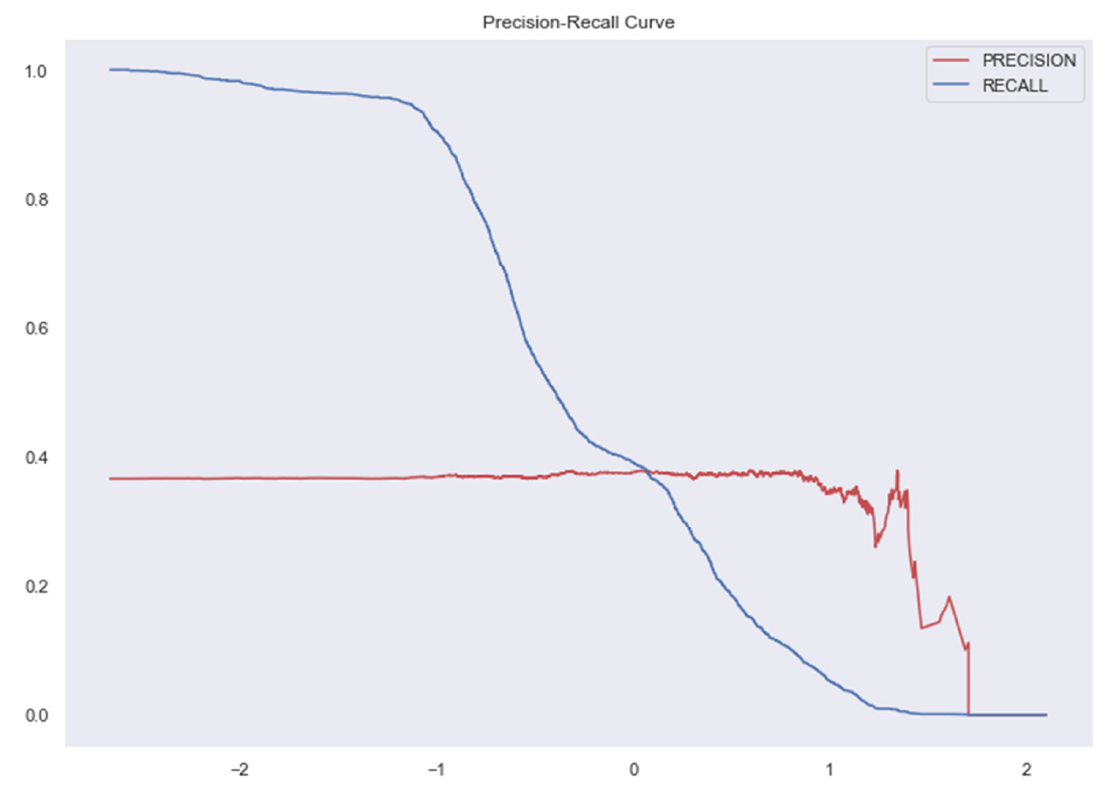
Figure 10. AUC and Precision-Recall Curve for Random Forest Classifier.